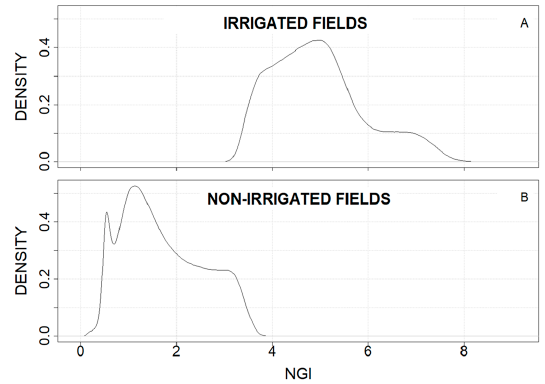
Figure 5. Empirical distributions of NGI index for irrigated and non-irrigated areas after the classification scheme has been